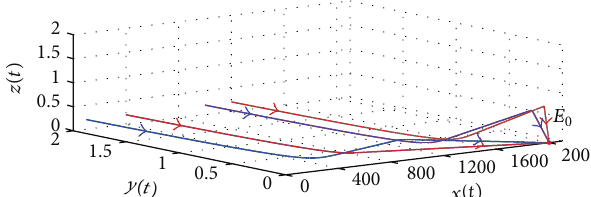
Figure 1: The phase diagram of system (2) with different initial values and different 𝜏 .